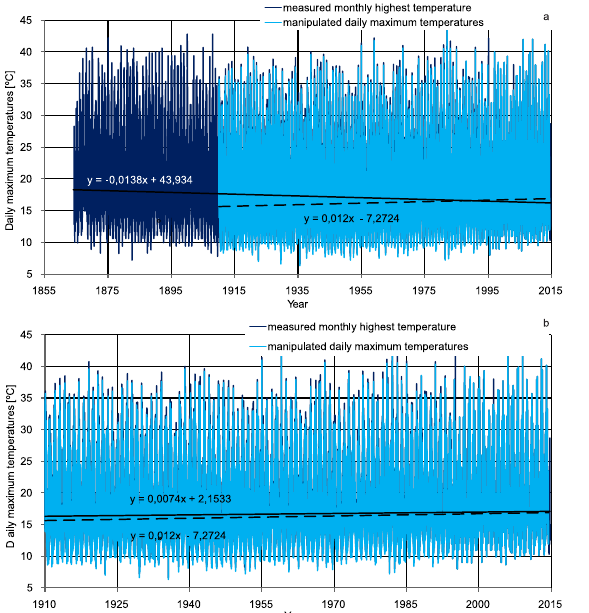
Fig. 2. Comparison of truly measured and ACORN manipulated daily maximum temperatures in Cape Otway Lighthouse: a) all the years of data; b) 1910 to present. Data from Australian Government Bureau of Meteorology (BOM 2014a, d) accessed October 10, 2014.